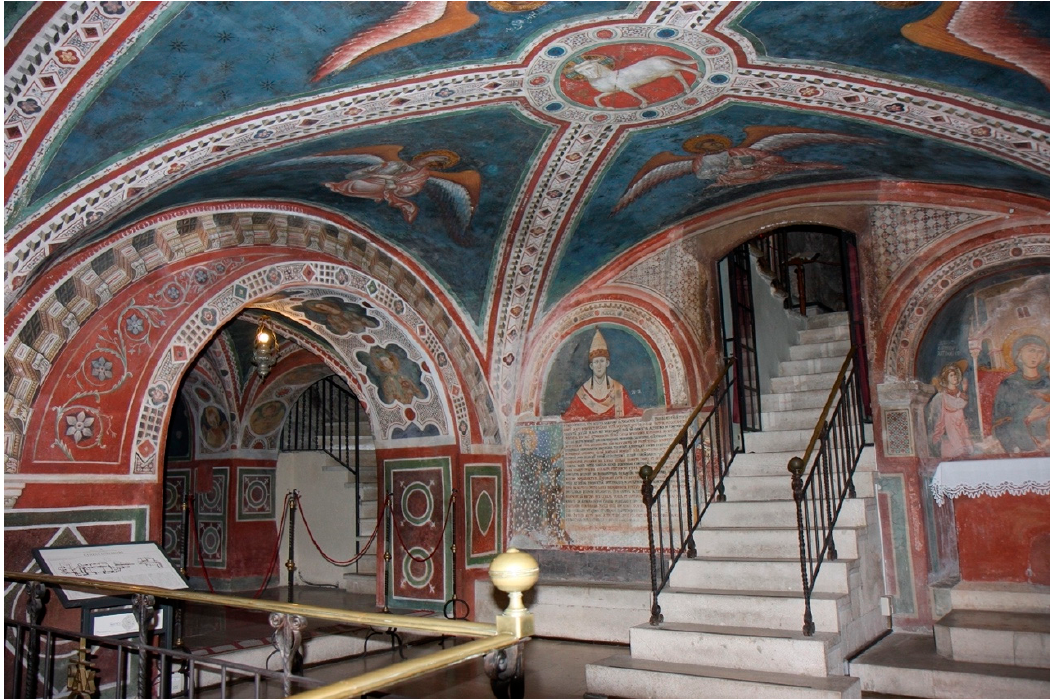
Figure 7. Sacro Speco, Subiaco (Italy), Lower Church. Landing hosting the fresco with the Bull of Innocent III. Photo: Roberta Cerone.